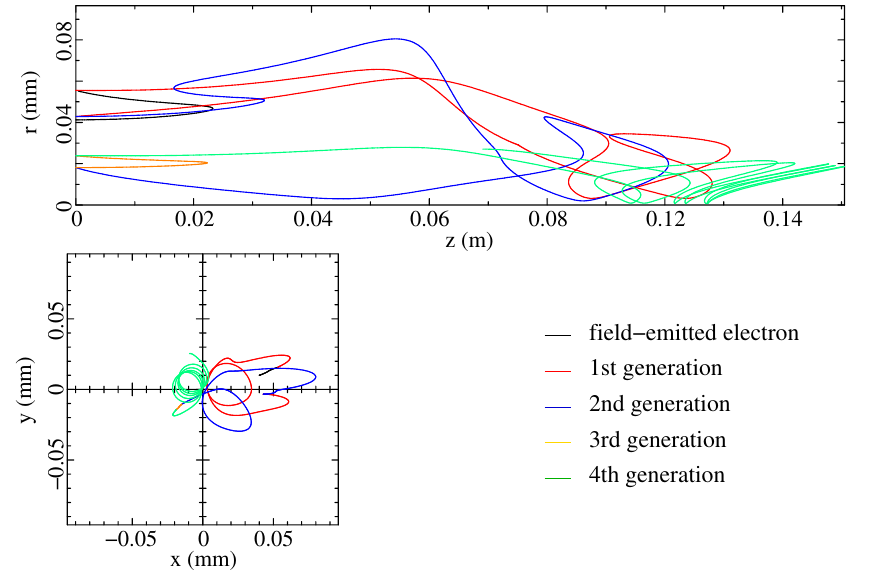
FIG. 15. (Color) One example of multipacting trajectories calculated with ASTRA for the PITZ gun.